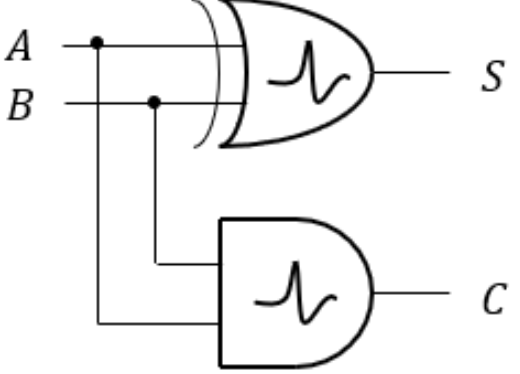
Figure 11. The network structure of the half